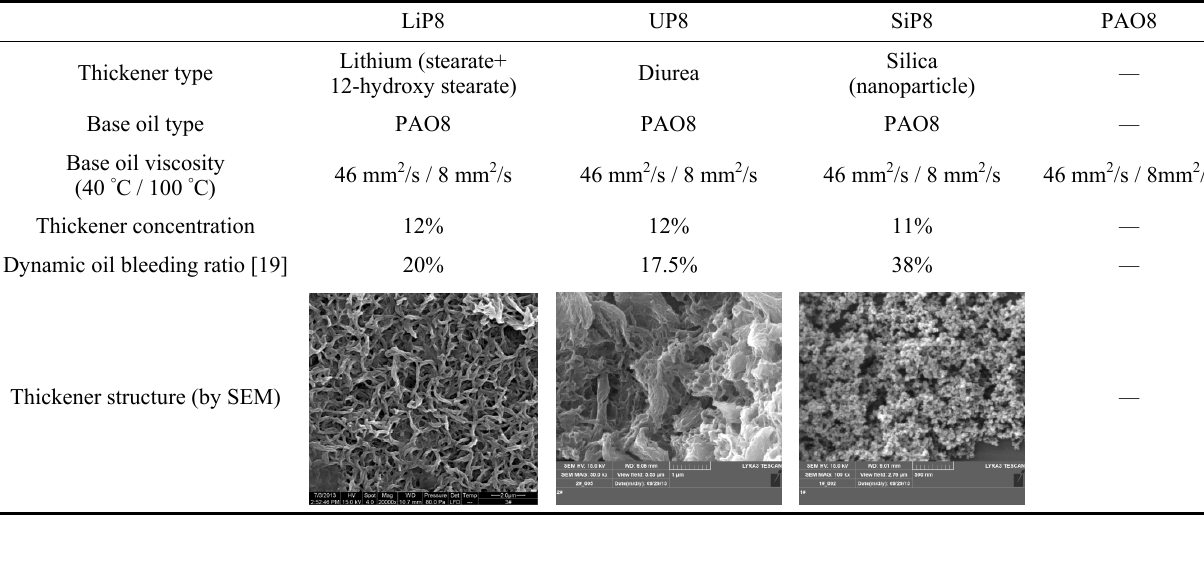
Table 1 Properties of the